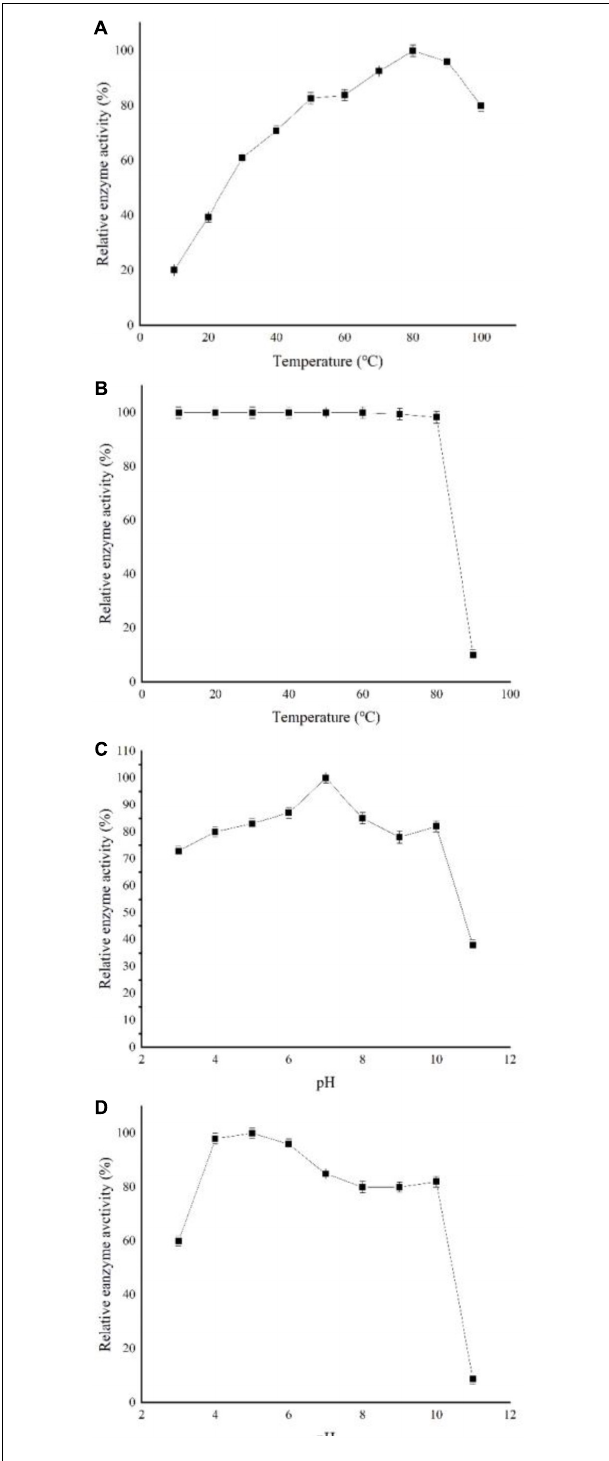
FIGURE 3 | Characterization of recombinant CGTase. (A) Optimum temperature, (B) temperature stability. Reaction mixtures contained 900 µ l soluble starch and 100 µ l CGTase in Na 2 HPO 4 -NaH 2 PO 4 buffer at pH 7 from 10 to 100 ◦ C for 10 min, (C) optimum pH, and (D) pH stability. Reaction mixtures contained 900 µ l soluble starch and 100 µ l CGTase in different buffers at pH 3–11 and were incubated at 80 ◦ C for 10